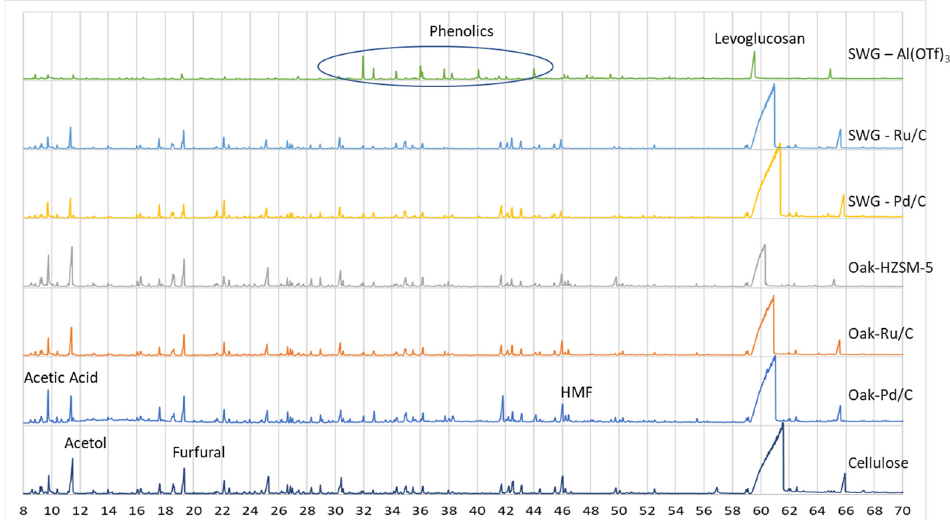
Figure 3. Pyrogram from Py-GC-FID of cellulosic pulps from lignin- fi rst fractionation in ethanol at 210 °C. Pyrolysis at 550 °C. 210 ◦ C. Pyrolysis at 550 ◦